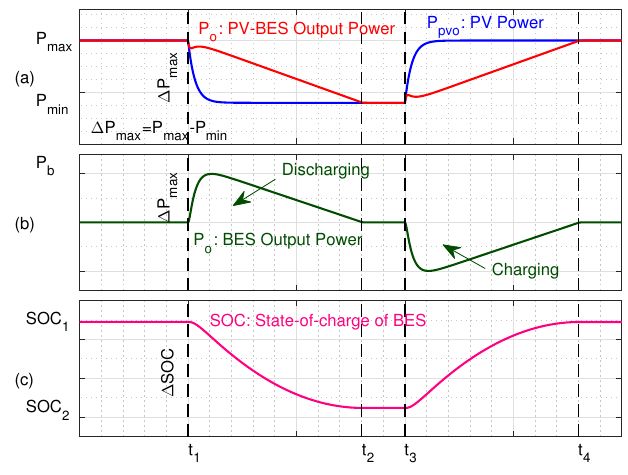
Figure 6. Operational scenario of the BES.